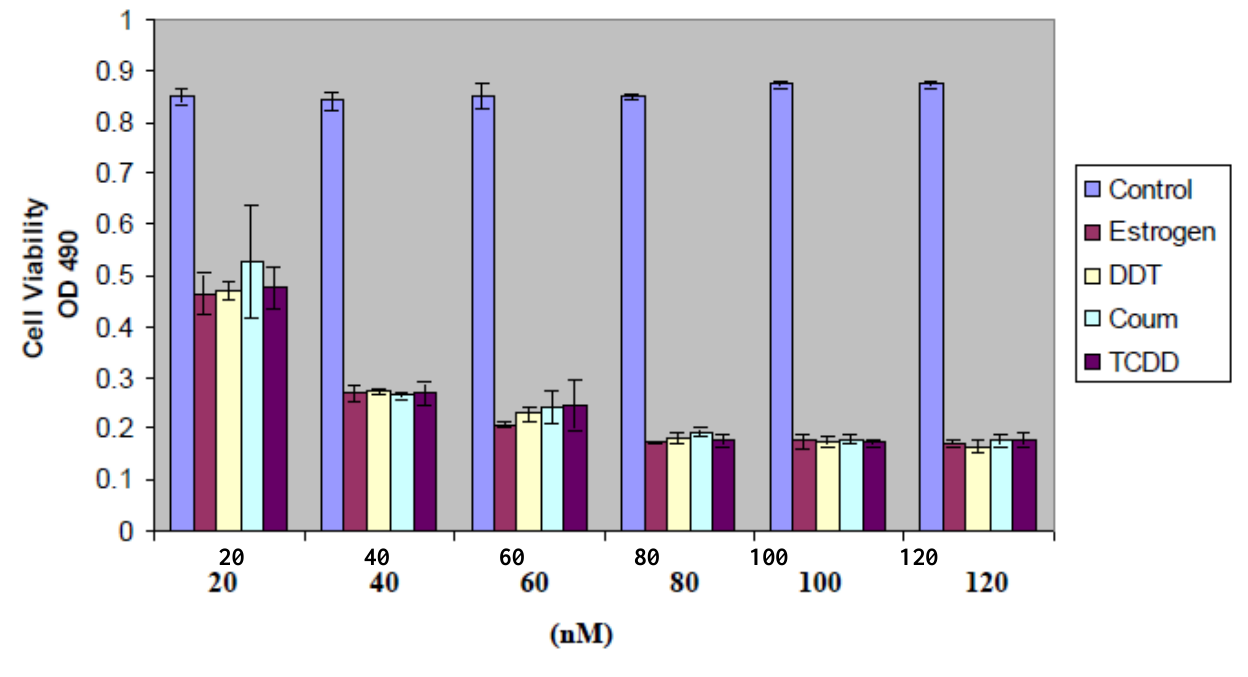
Figure 1. HeLa cell viability over 72 h exposure to 20 to 120nM 17- β -estradiol (E), DDT (D), Coumestrol, TCDD vs . control/solvents (C). 17- β -estradiol, DDT, Coumestrol and TCDD had profound effects on HeLa cell